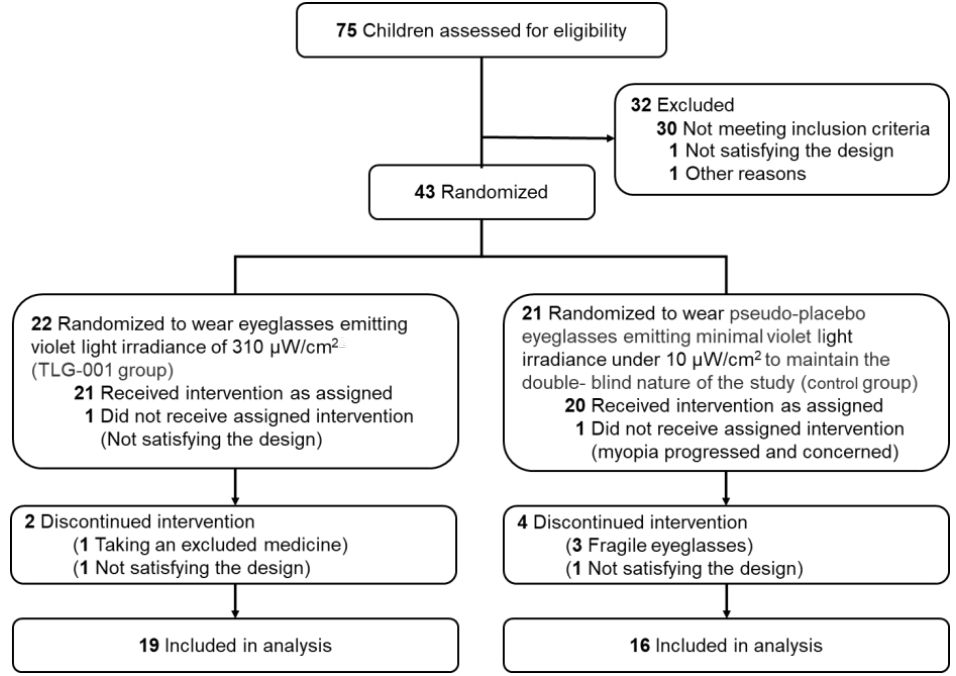
Figure 2. Flowchart of this double-blind randomized pilot clinical trial time points and number of participants. Table 1. Characteristics of the 82 eyes of 41 participants.